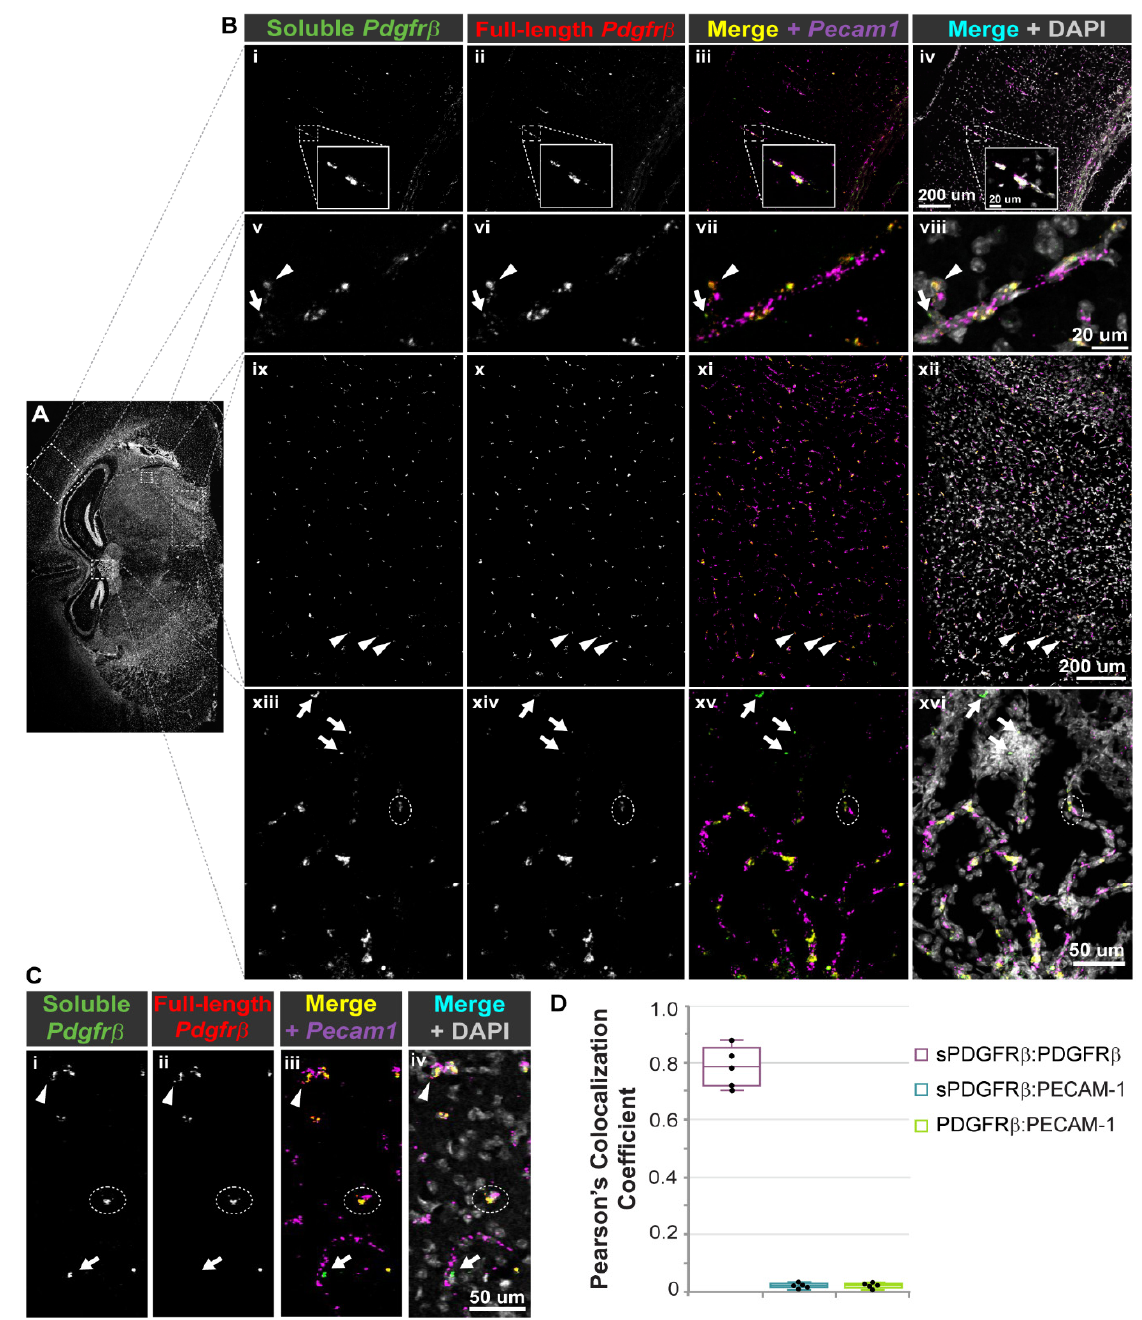
Figure 4. RNA-Scope ® Probes Facilitated Detection of Soluble and Full-length Pdgfr β Transcripts Adjacent to Pecam1 mRNA in the Adult Mouse Brain. ( A ) Representative coronal section of an adult mouse brain (from n = 4 biological replicates, both sexes) labeled for cell nuclei (DAPI) with white, dotted boxes indicating regions visualized at a higher-power magnification shown in ( B ). ( B ) High-power magnification images of mouse cerebral cortex and white matter (i–iv with associated inset), thalamus (v–viii), hypothalamus (ix–xii), and along the floor of the third ventricle, adjacent to the thalamus (xiii–xvi) labeled for soluble Pdgfr β transcripts (i, v, ix, xiii; green in iv, viii, xii, xvi), and full-length Pdgfr β transcripts (ii, vi, x, xiv; red in iv, viii, xii, xvi). A merge of these two signals appears yellow in iii, vii, xi, and xv. While most of these signals overlap, we found instances where the signal was stronger for full-length Pdgfr β (arrowheads, ix–xii) or soluble Pdgfr β (arrows,